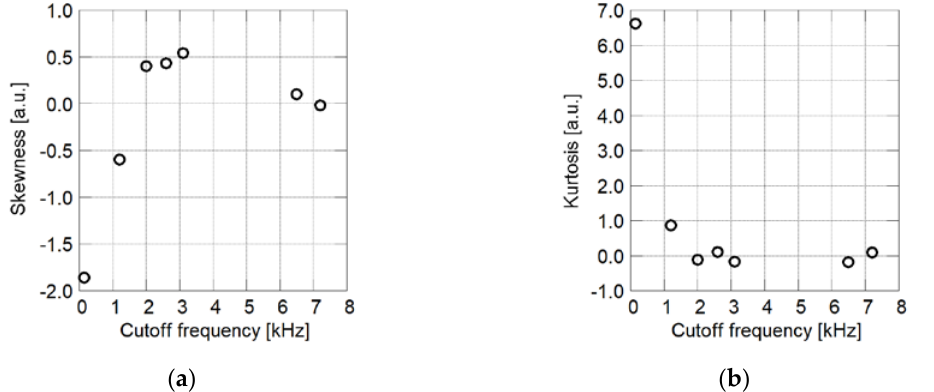
Figure 15. Statistics of brightness histograms of SEM images related to cutoff frequency. ( a ) Skewness; ( b ) Kurtosis.